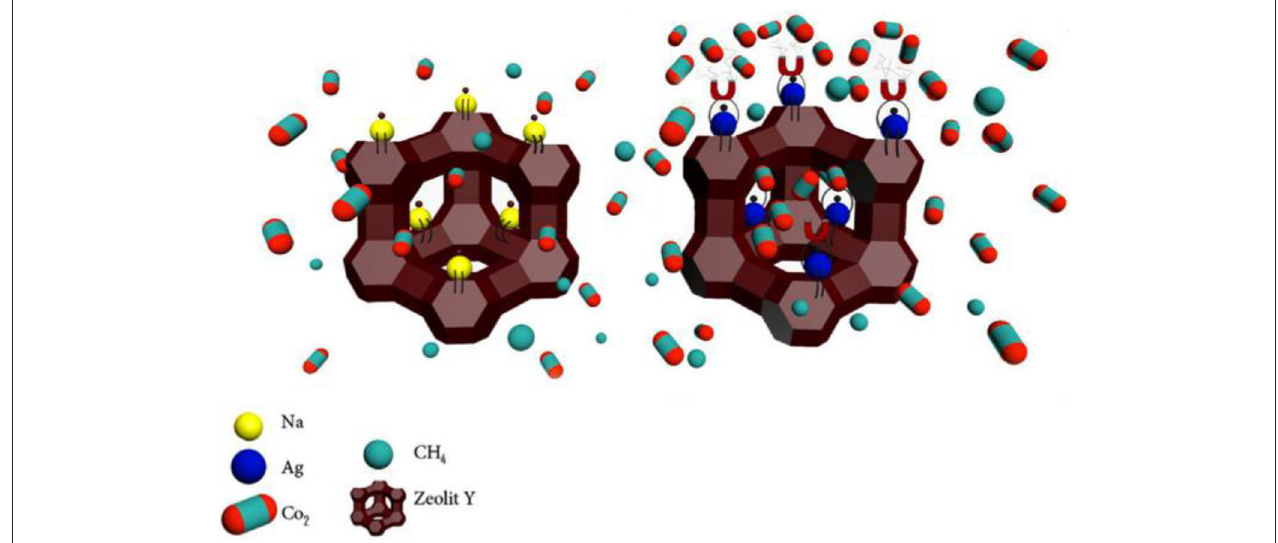
FIGURE 6 | Schematic depiction of CO 2 -facilitated transport across the Ag + ion-exchanged zeolite-Y. Reproduced from Ebadi Amooghin et al. (2016). Copyright obtained from Elsevier (license number 4681850860075).